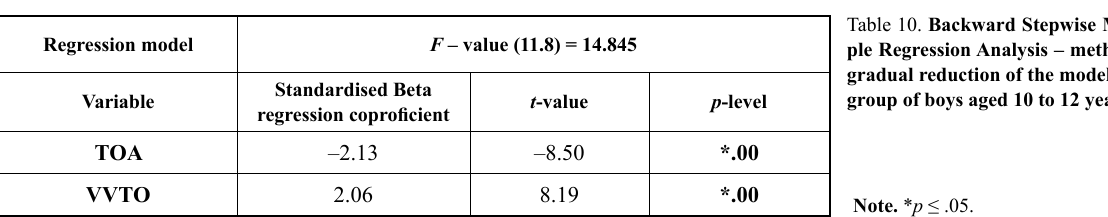
Table 10. Backward Stepwise Multi -